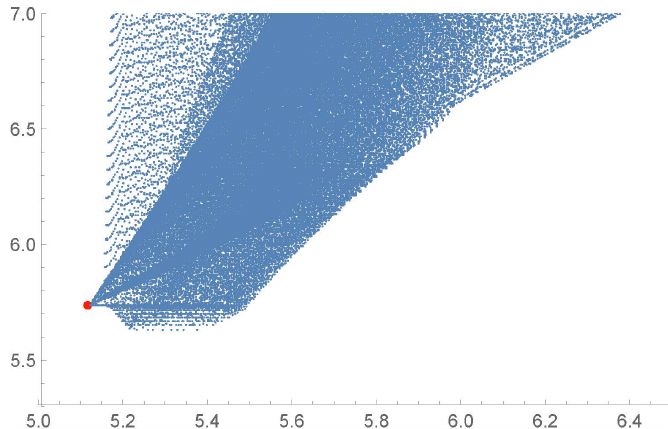
Figure 4. Performance analysis of A 0 ( α , B ) for various values of parameters α , B . Blue points ( a , w ) correspond to ( a , w ) -efficient algorithms A